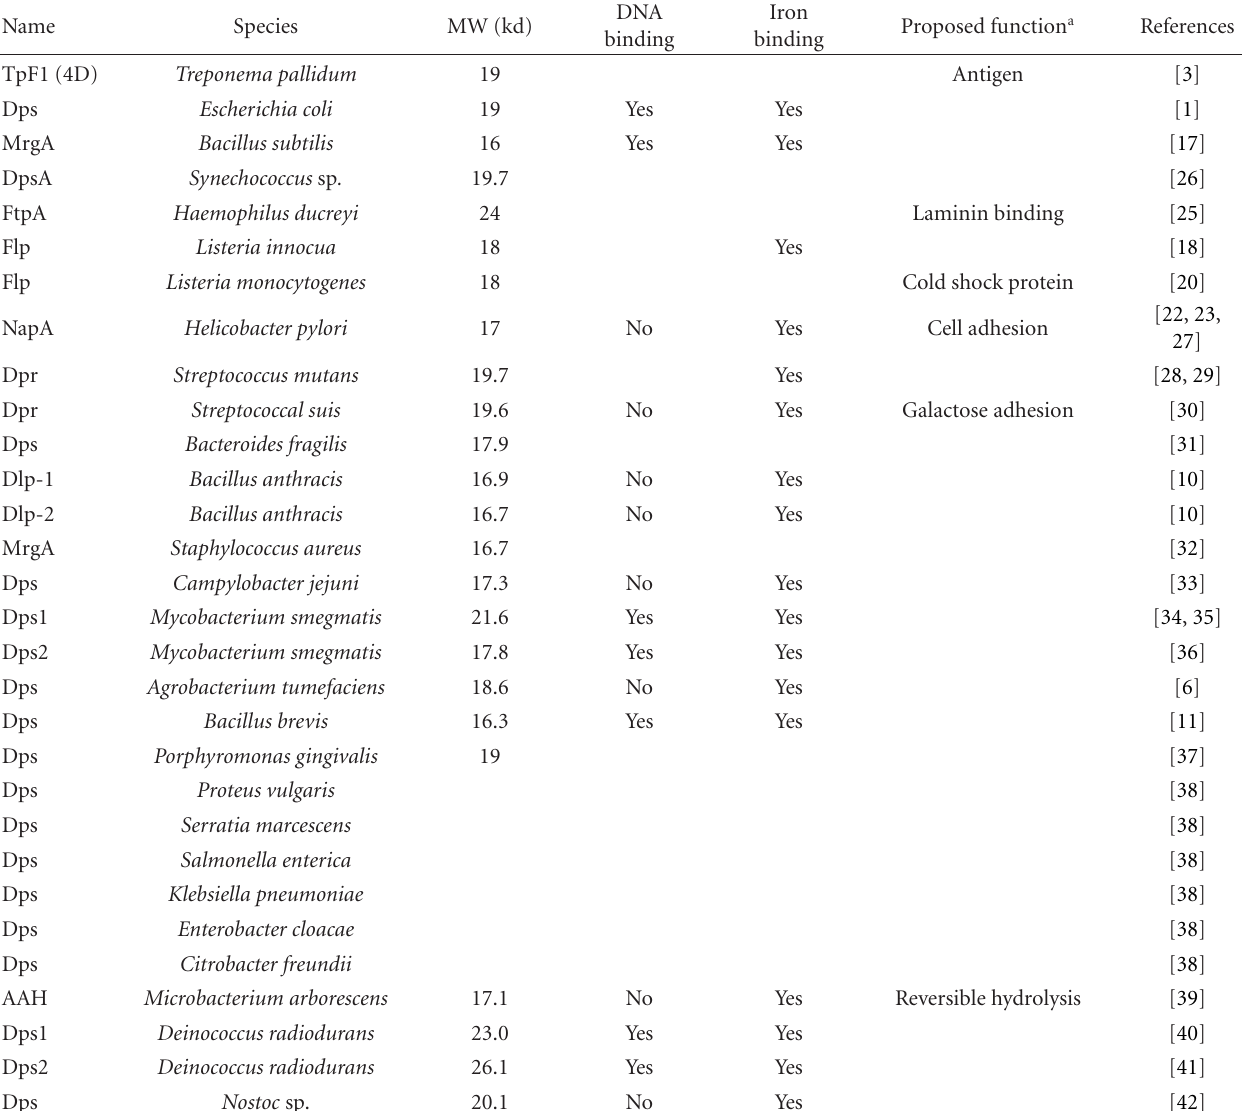
Table 1: Reported Dps-like proteins and their proposed